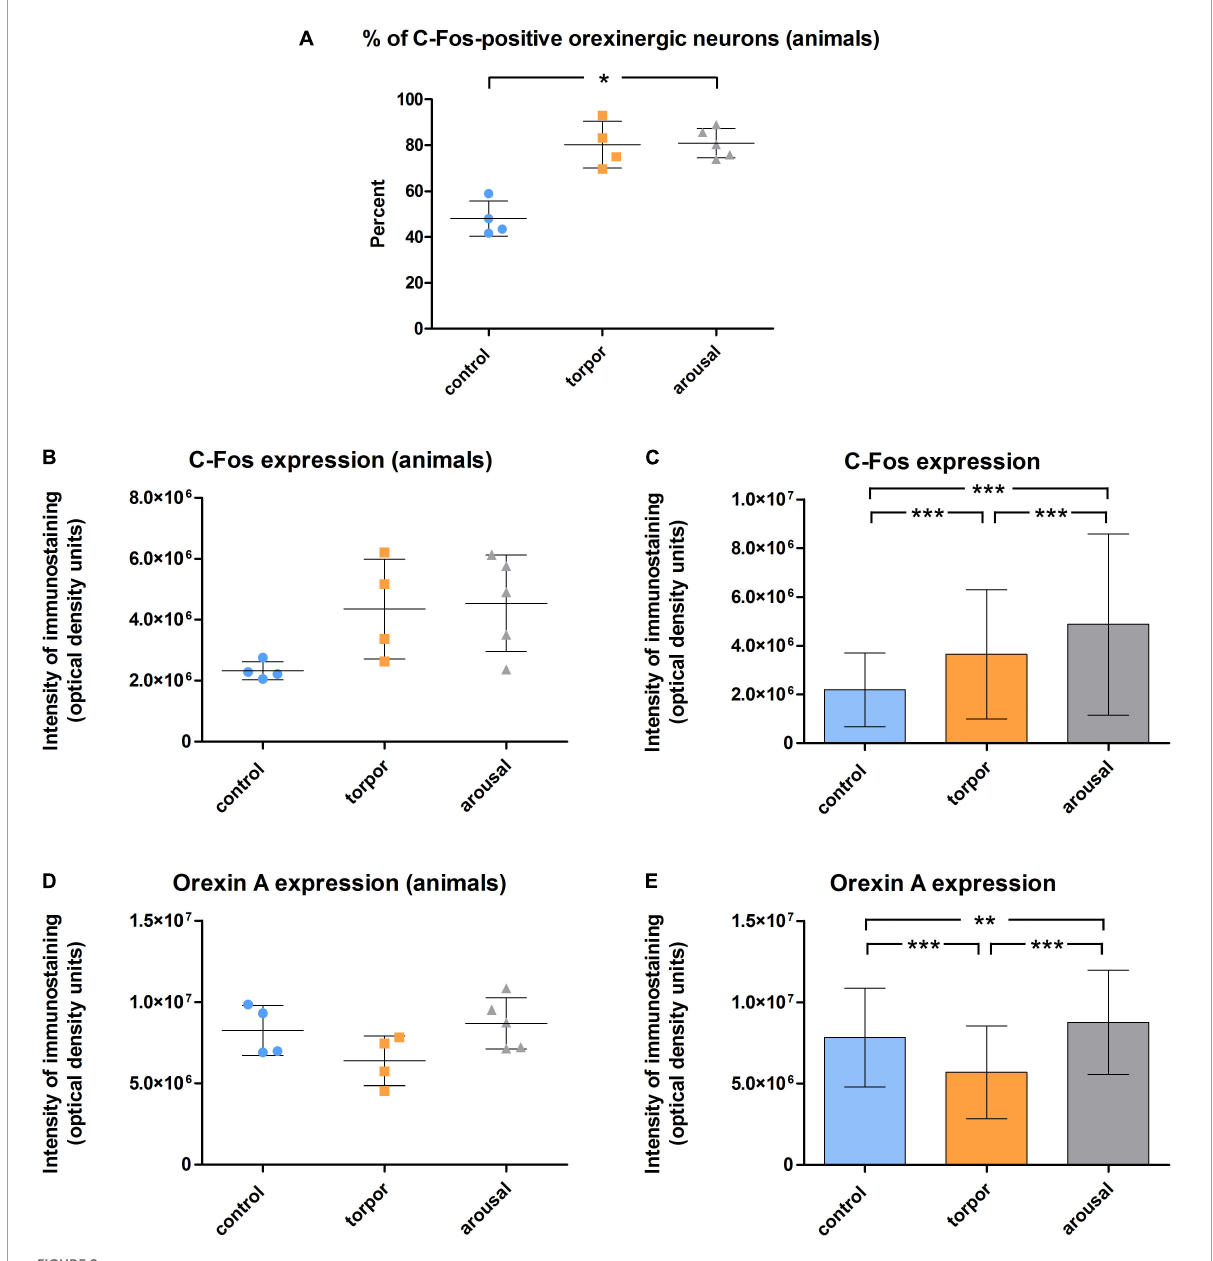
FIGURE8 (A) Graph showing the mean ± SD values of the percentage of orexinergic neurons that showed C-Fos immunostaining in hamsters at euthermia ( n = 4), torpor ( n = 4), and arousal ( n = 5). (B–E) Graphs showing mean ± SD values of C-Fos (B) and OXA (D) immunostaining of orexinergic neurons. Panels (C,E) show respectively mean ± SD values of C-Fos and OXA immunostaining of orexinergic neurons when all C-Fos-ir orexinergic neurons from the animals in each experimental condition were considered together (control, n = 177; torpor, n = 201; arousal, n = 288). See Tables 2 , 3 for statistical comparisons and p -values. * p ≤ 0.05, ** p ≤ 0.005, *** p ≤